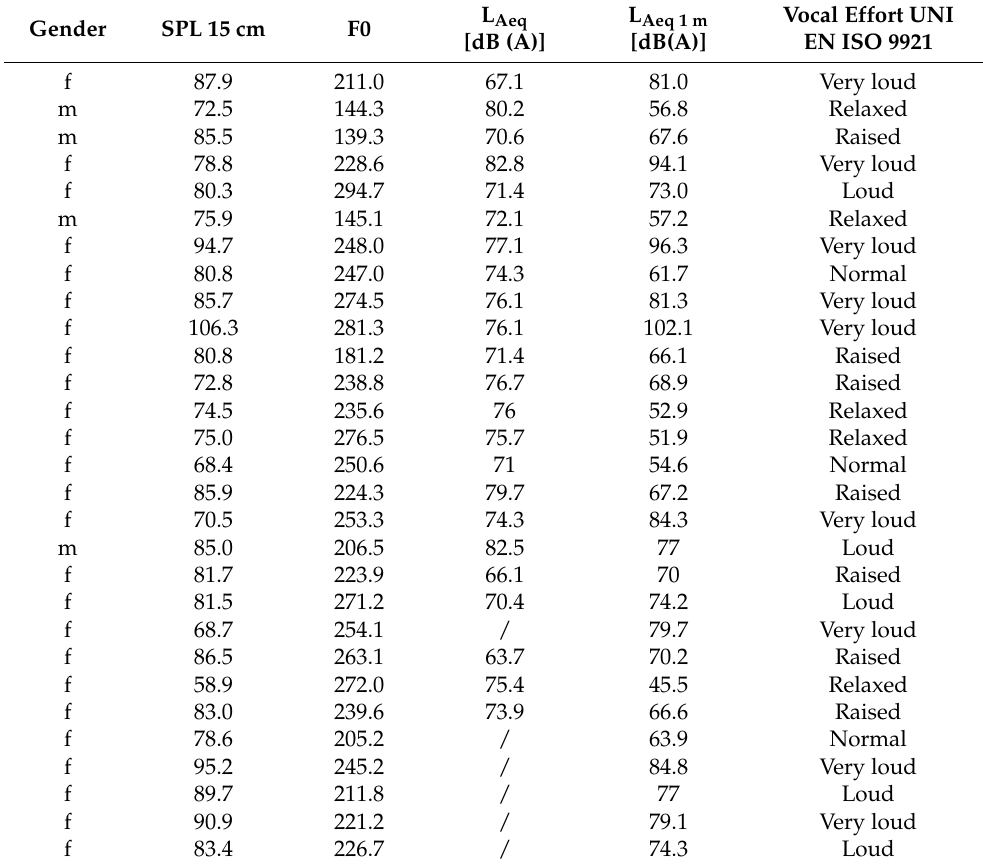
Table 6. Average SPL values measured at 15 cm and average L Aeq 1 m [dB(A)] from the speaker for the entire measurement duration. Average L Aeq [dB(A)] values referred to measurements with a